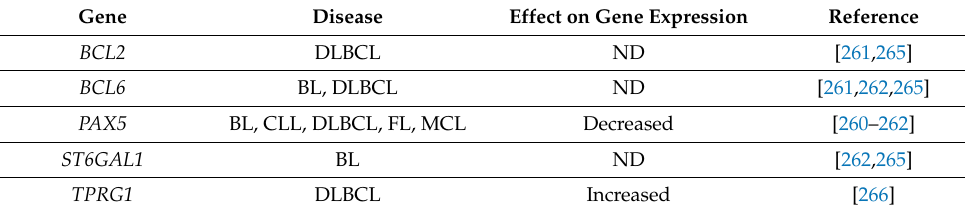
Table 4. Somatic mutations in enhancer regions identified in B-cell